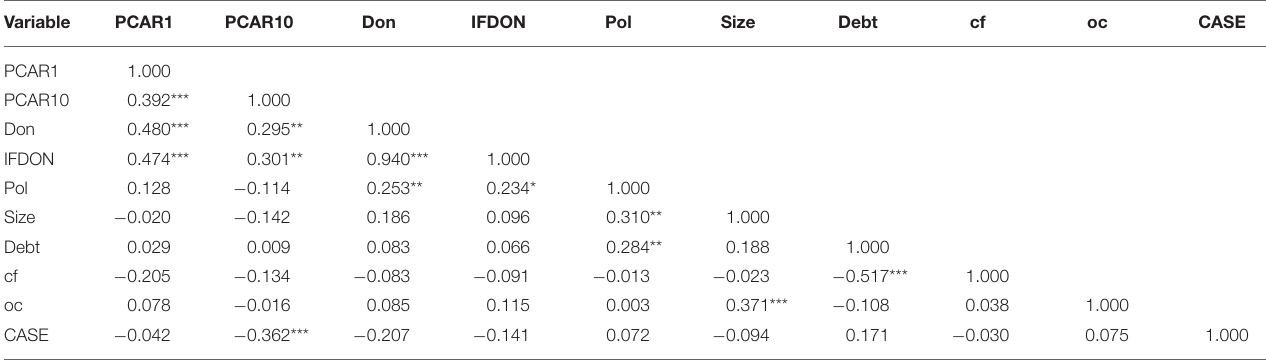
TABLE 5 | Correlation coefficients of variables of sample firms.